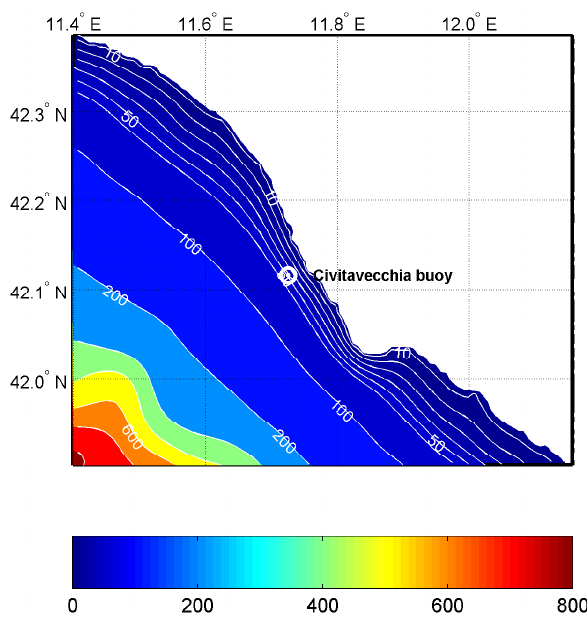
s at Civitavecchia.